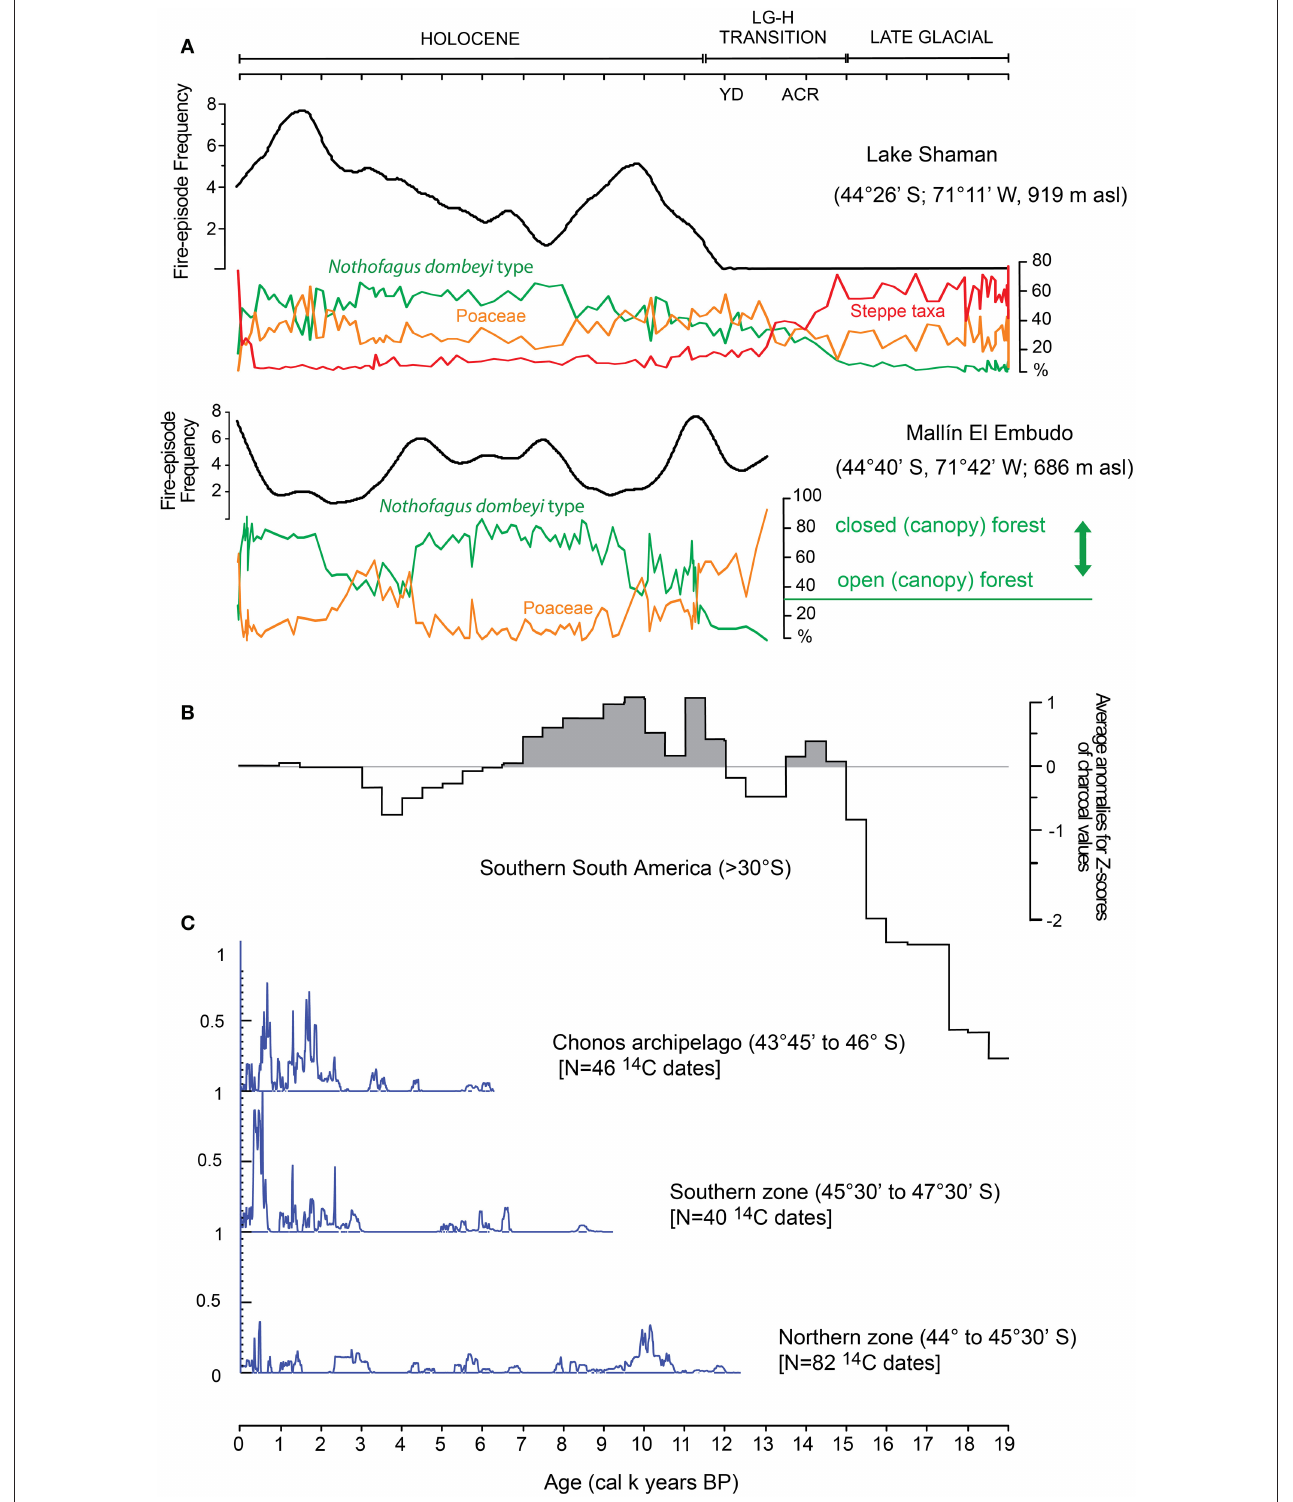
FIGURE 3 | (A) Summary of main pollen taxa and fire-episode frequencies from Mallín El Embudo (de Porras et al., 2014) and Lake Shaman (de Porras et al., 2012) sedimentary records, (B) summary of paleofire activity in western South America ( > 30 ◦ S, after Power et al., 2008), and (C) summed probabilities of the 14 C calibrated age distributions for archeological sites in CWP partitioned by sub-regions.